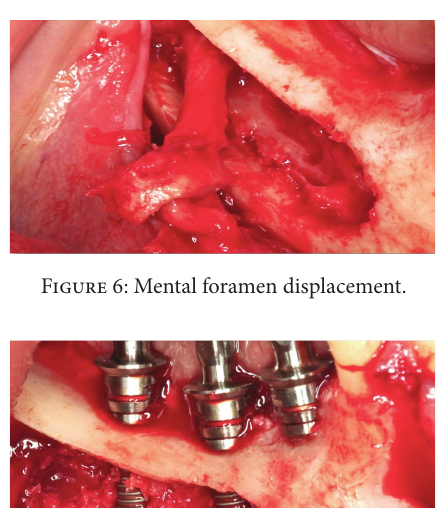
Figure 5: Section of the incisive nerve.